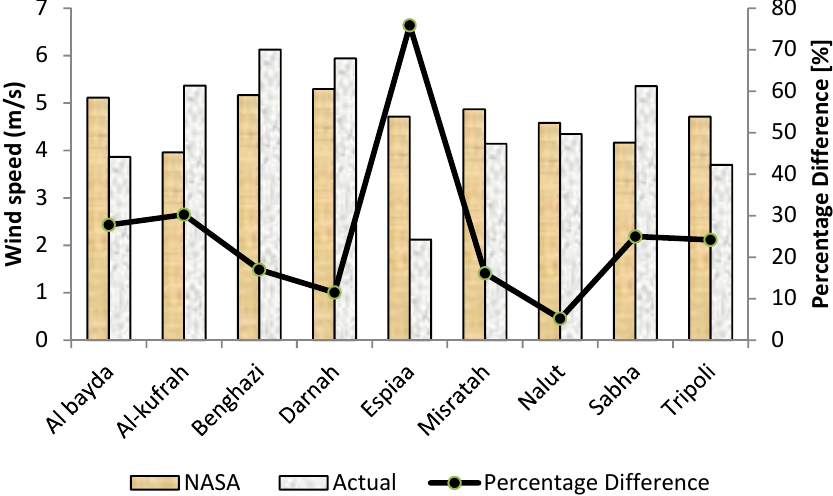
Figure 5. Comparison between actual and NASA data of the mean annual and percentage di ff erence between both data.